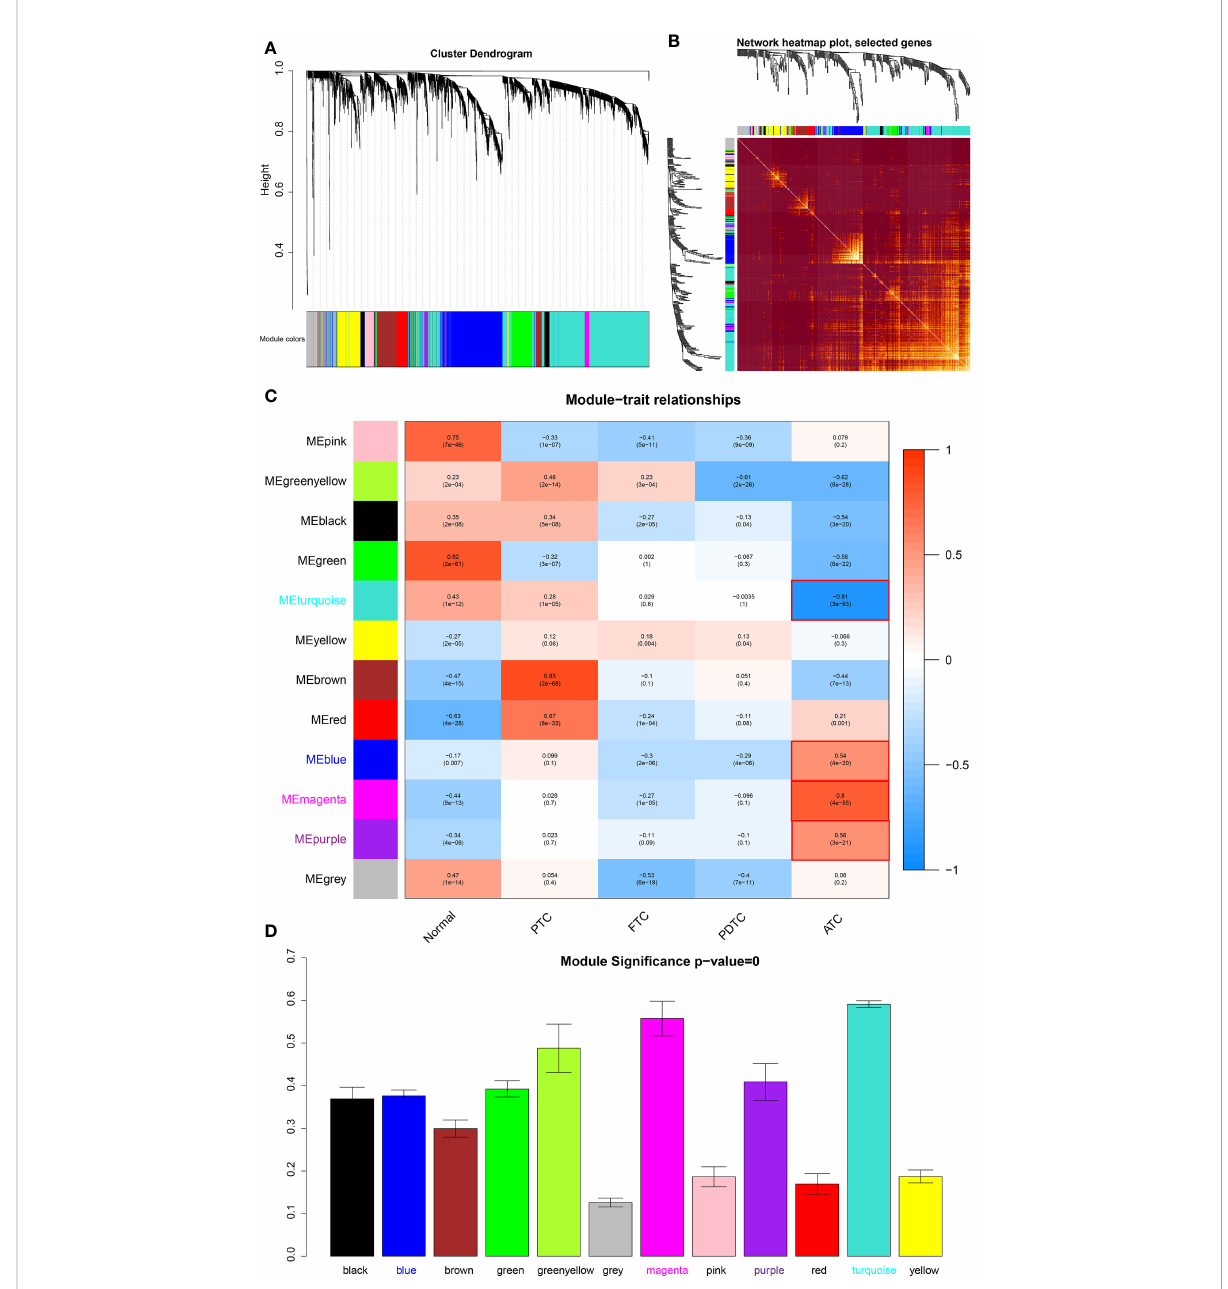
FIGURE 1 Module detection and ATC-speci fi c module identi fi cation. (A) Hierarchical clustering dendrogram of the top 20% variant genes. The color row underneath the dendrogram displays the corresponding module assignment determined by the Dynamic Tree Cut. One color represents one module. (B) Heatmap diagram of topological overlap in the gene network drawn based on 400 selected genes. Each row and column correspond to a gene, dark red color represents low topological overlap, and a gradually lighter color denotes higher topological overlap. Lighter squares along the diagonal correspond to modules. The gene clustering dendrogram and module assignment are exhibited along the left and top. (C) Heatmap of the correlations between module eigengenes and various subtypes of thyroid cancer samples, including normal thyroid samples. The table is color-coded by correlation based on the color legend, blue color represents negative correlation, while red color represents positive correlation. The number in the rectangle is the concrete correlation coef fi cient and p-value (in the bracket). Modules marked in red are those that are signi fi cantly positively or negatively correlated only with ATC. (D) Barplot of mean ATC-based GS across modules (module signi fi cance). The higher the mean GS in a module, the more signi fi cantly correlated the module is to ATC. Normal, normal thyroid tissue samples; PTC, papillary thyroid carcinoma; FTC, follicular thyroid carcinoma; PDTC, poor-differentiated thyroid carcinoma; ATC, anaplastic thyroid